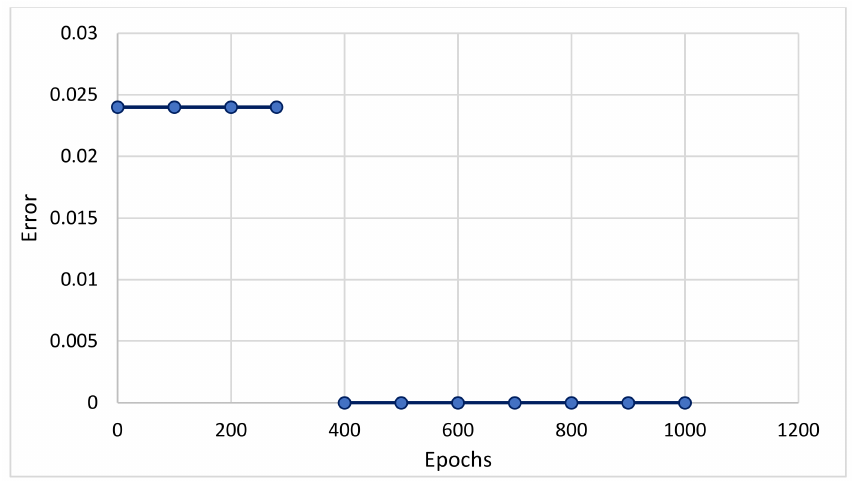
Figure 4. Training